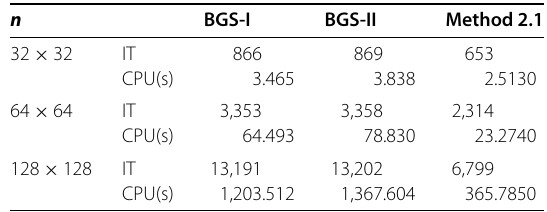
Table 2 The comparison of computational results among the BGS-I, BGS-II, Method 2.1 n